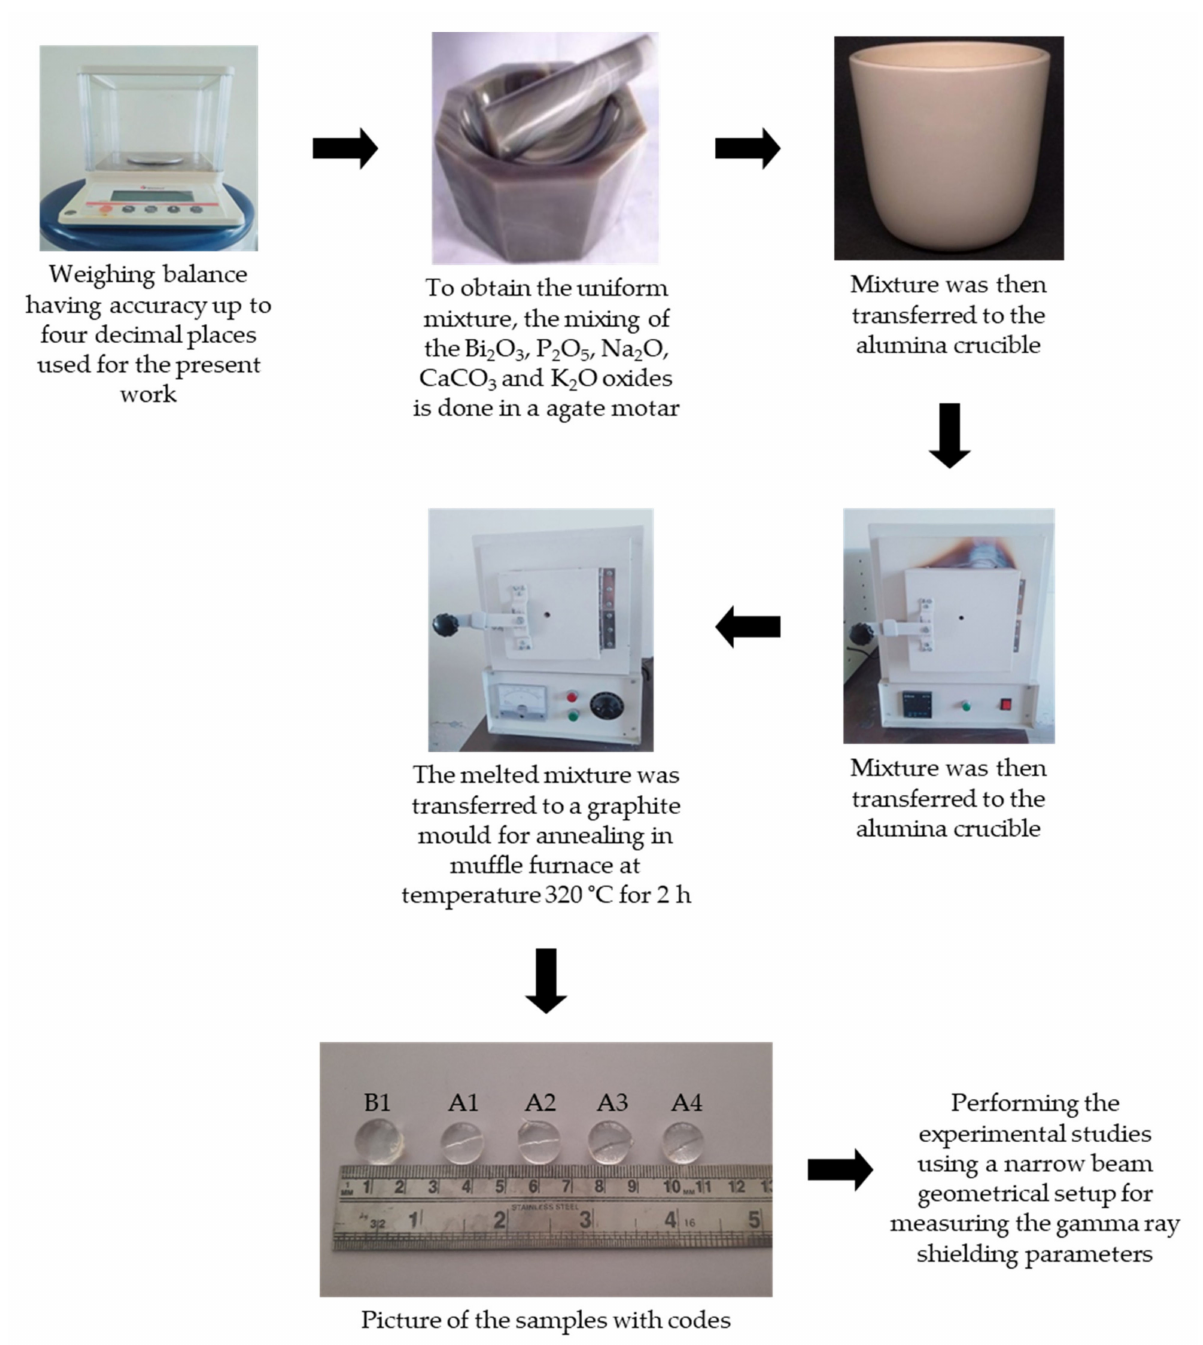
Figure 1. Graphical procedure for the preparation of the prepared